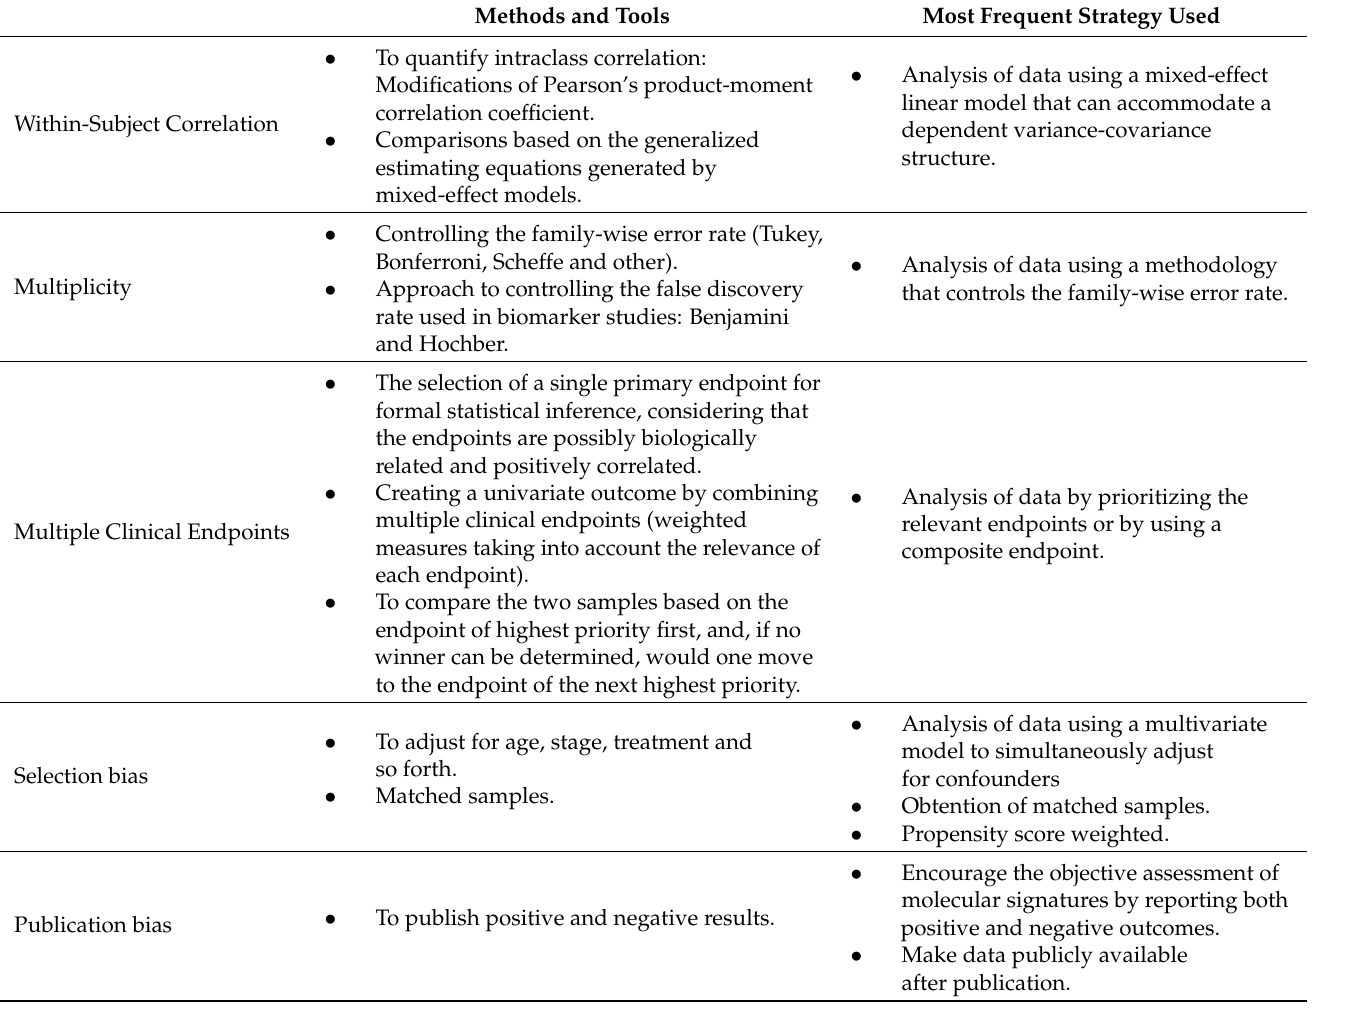
Table 1. Summary of the quantity of information found by type of data. Methods and Tools Most Frequent Strategy